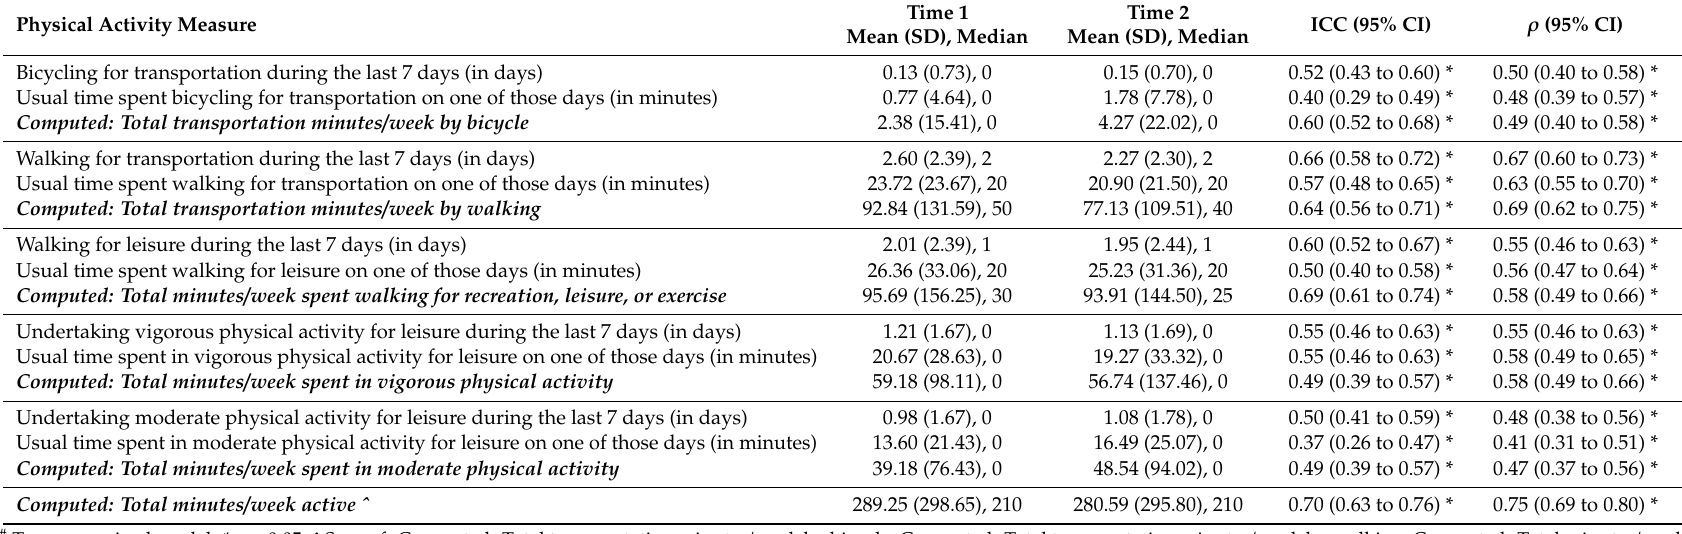
Table 3. Intraclass Correlations (ICC) # and Spearman’s rank correlation ( ρ ) for self-reported perceived neighbourhood physical activity between Time 1 and Time 2 for all participants ( n =